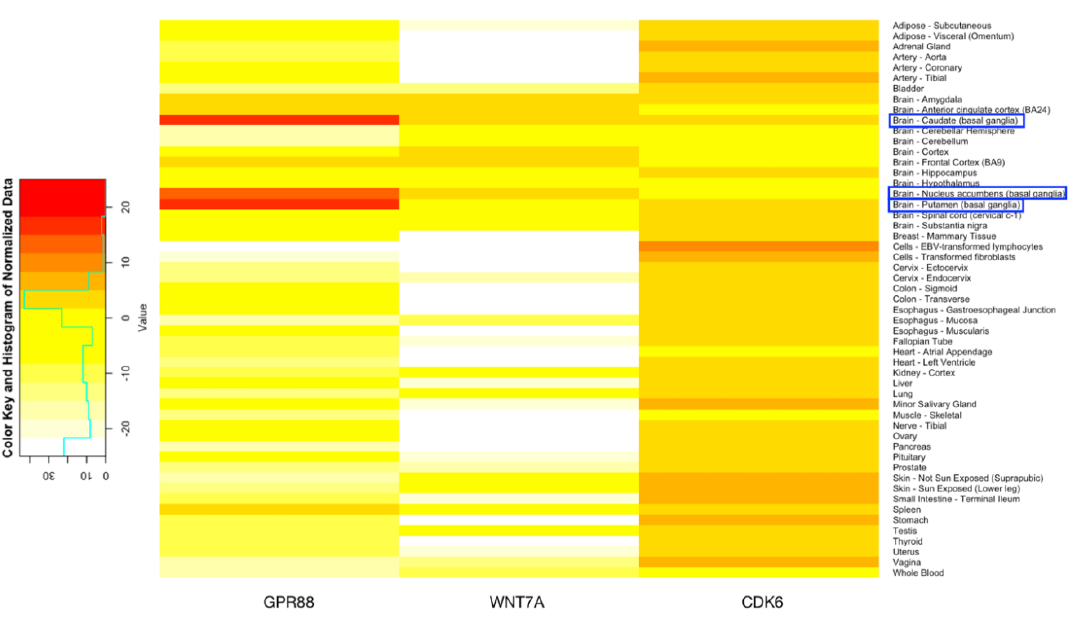
Figure 4. Expression data of the genes GPR88, WNT7A, and CDK6 obtained from GTEx.